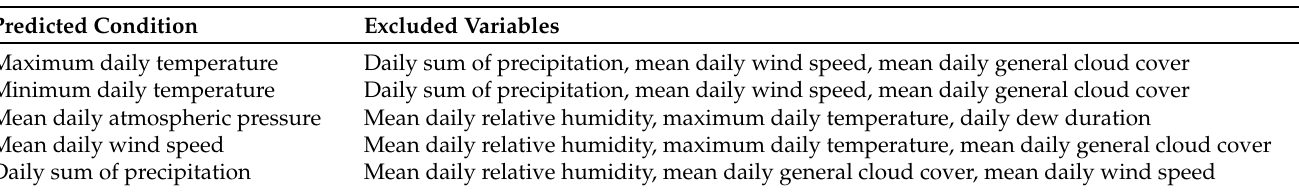
Table 7. The training variables excluded from the model based on the variable selection.